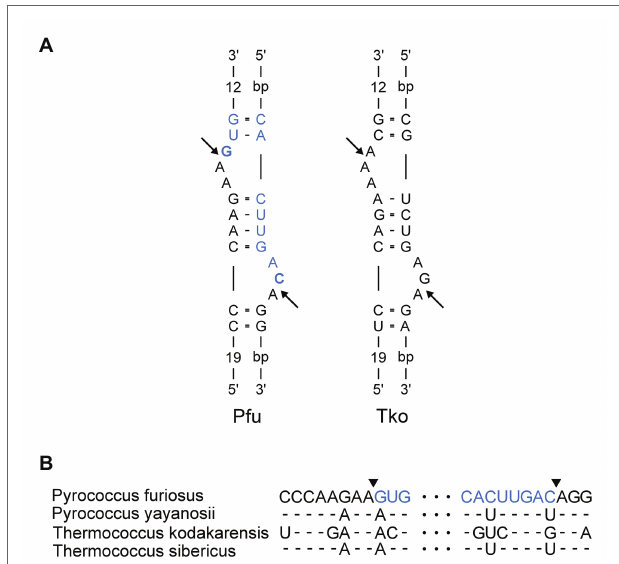
FIGURE 3 | (A) Bulge-Helix-Bulge (BHB) motif involved in processing of Pyrococcus furiosus LSU rRNA. The arrows indicate canonical cleavage sites that will result in circularization of the rRNA. The mature rRNA in Pfu is colored in blue. The nucleotides that are joined to form the circularization junction in Pfu are in bold. Pfu: Pyrococcus furiosus . Tko: Thermococcus kodakarensis . (B) Alignment of sequences in the LSU BHB motif in species of Thermococcales. Arrowheads and color coding in the Pfu sequence corresponds to (A)